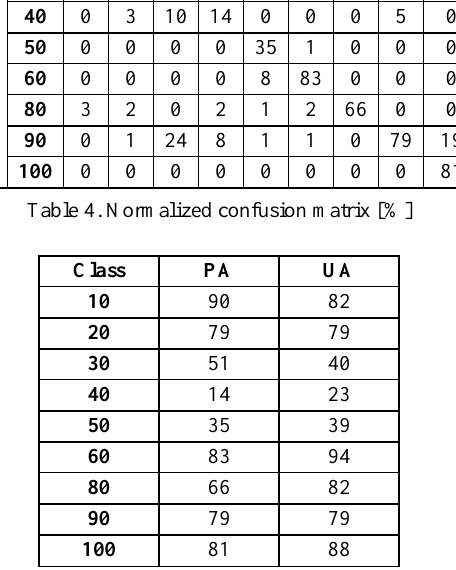
Table 5. Producer’s and User’s accuracy